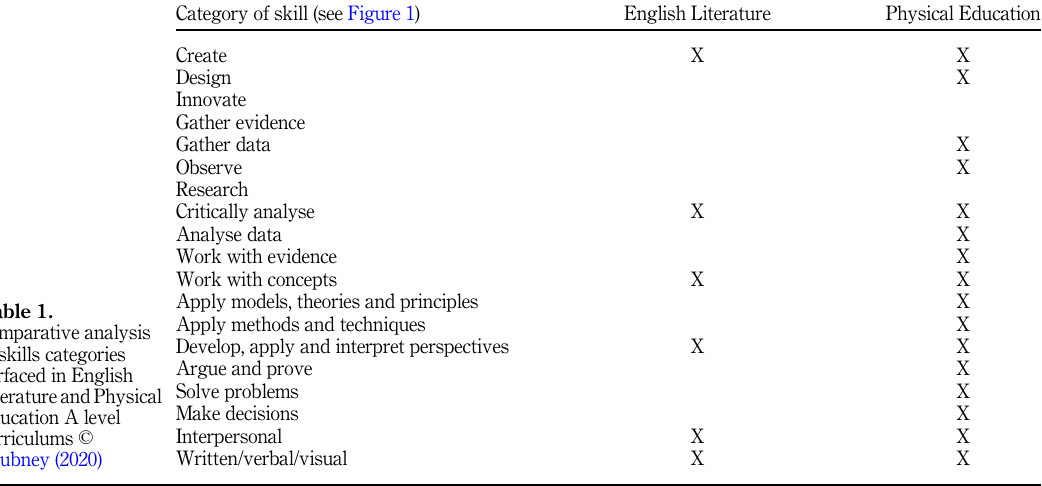
Table 1. Comparative analysis of skills categories surfaced in English LiteratureandPhysical Education A